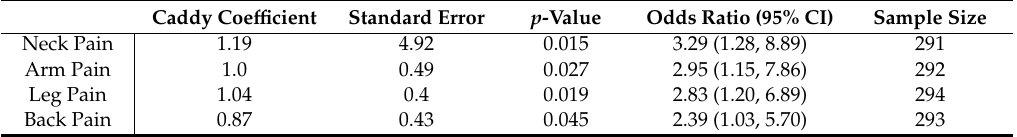
Table 2. Logistic Model Regression Analysis Estimating the Odds for Musculoskeletal Pain in Caddies Compared to Non-Caddies Adjusting for